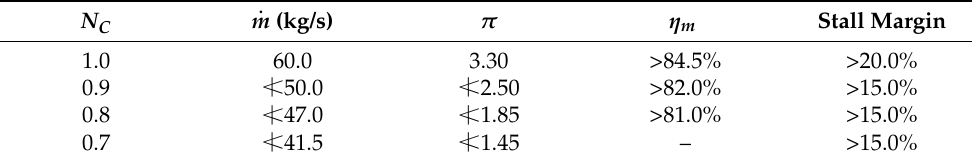
Table 1. The objective aerodynamic performance at different rotating speeds.